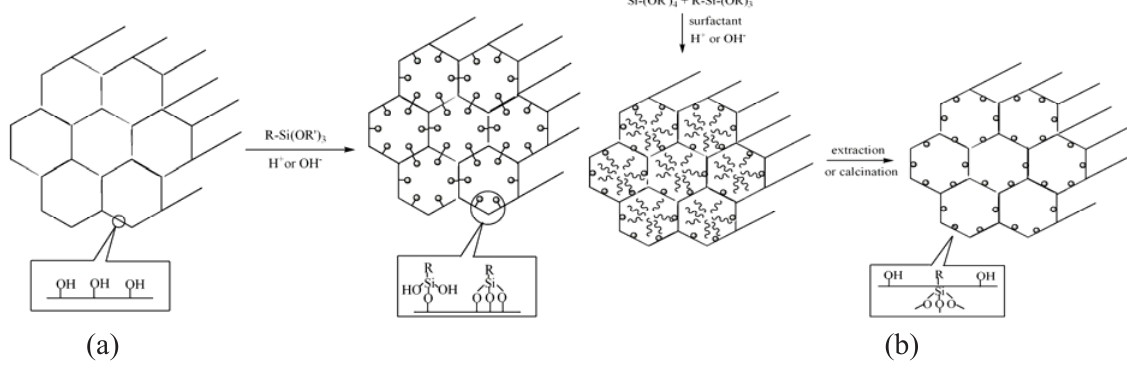
Figure 1. (a) Postsynthetic functionalization and (b) co-condensation methods for organic modification of mesoporous